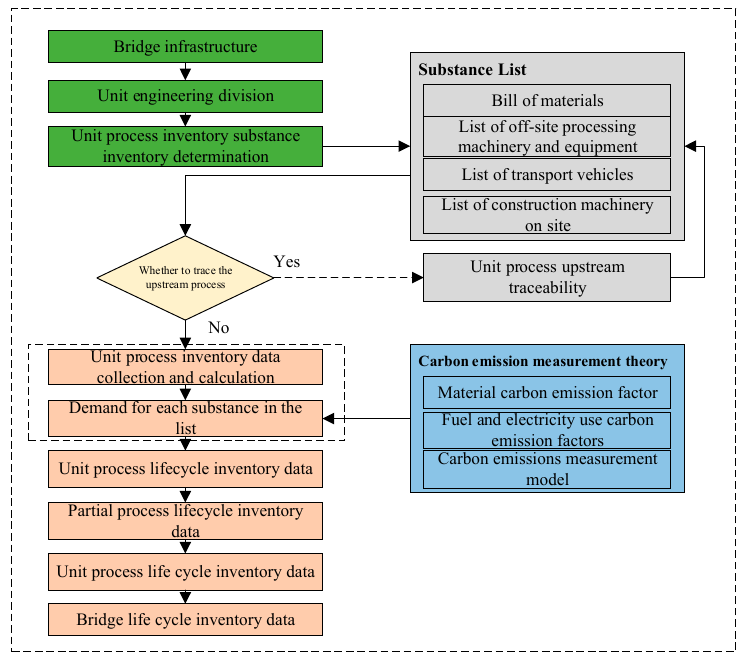
Figure 2. Modeling idea of the bridge engineering materialization stage.